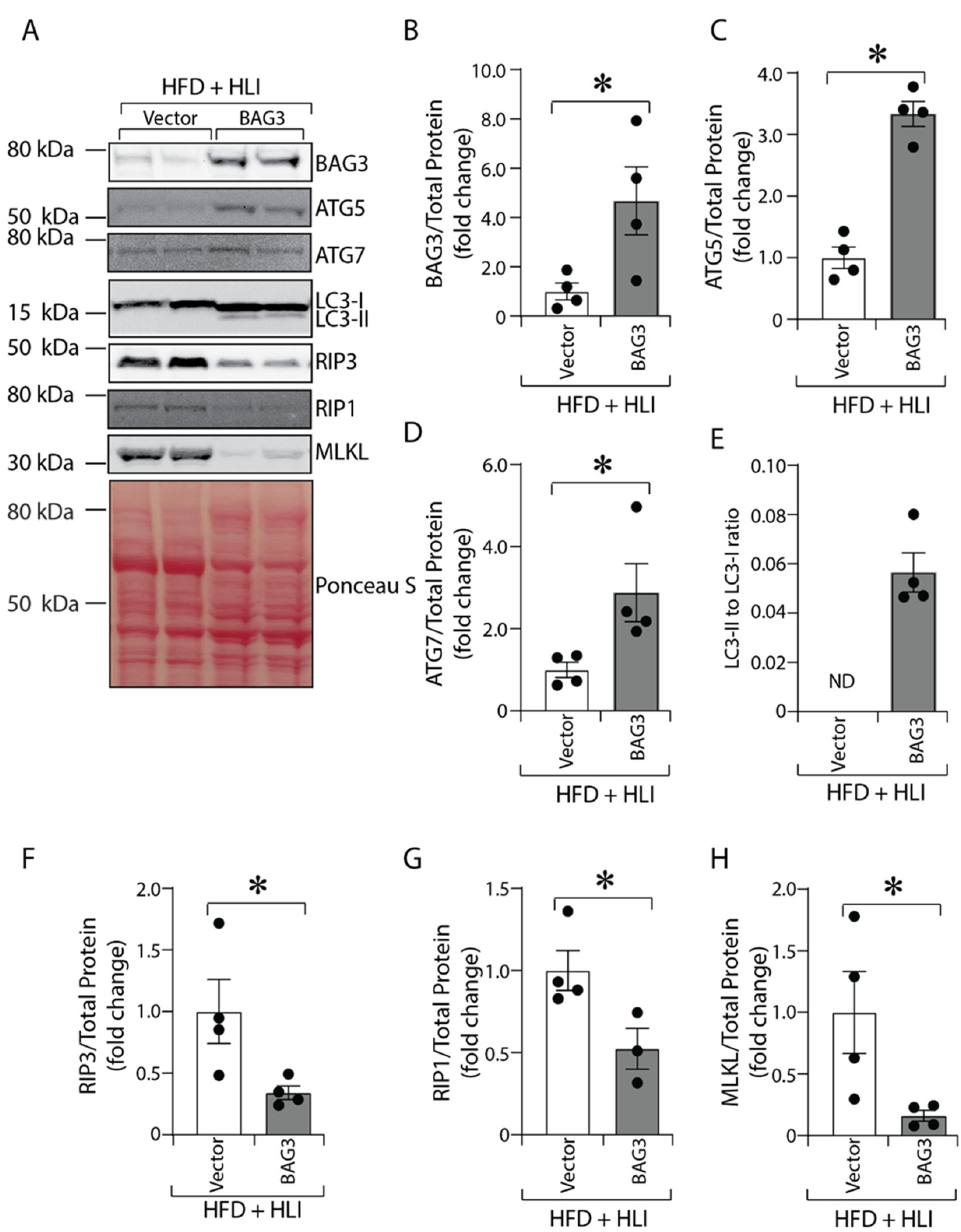
Figure 5. BAG3 overexpression improves autophagy and decreases necroptosis in ischemic skeletal muscles in diabetes. C57BL/6J mice were fed with HFD for 16 weeks. Mice were treated with AAV6-CMV (Vector) or AAV6-BAG3 (BAG3). After 7 days of HLI, GA muscle samples were collected, protein lysates were prepared, and BAG3 ( A , B ) n = 4, ATG5 ( A , C ) n = 4, ATG7 ( A , D ) n = 4, LC3-II/-I ratio ( A , E ) n = 4, RIP3 ( A , F ) n = 4, RIP1 ( A , G ) n = 3–4, and MLKL ( A , H ) n = 4 were quantified by Western blotting. The protein band was quantified and normalized to total protein from Ponceau S staining. The results are presented as fold changes vs. control vector. ND = not determined (because of undetectable band intensity). All the values are mean ± SEM. * p < 0.05 vs.